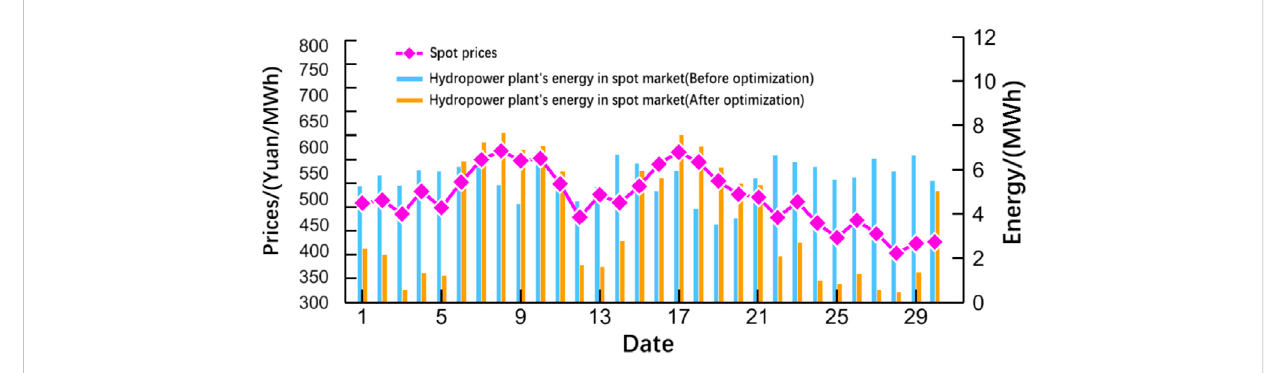
FIGURE 8 Energy portfolio before and after optimization.